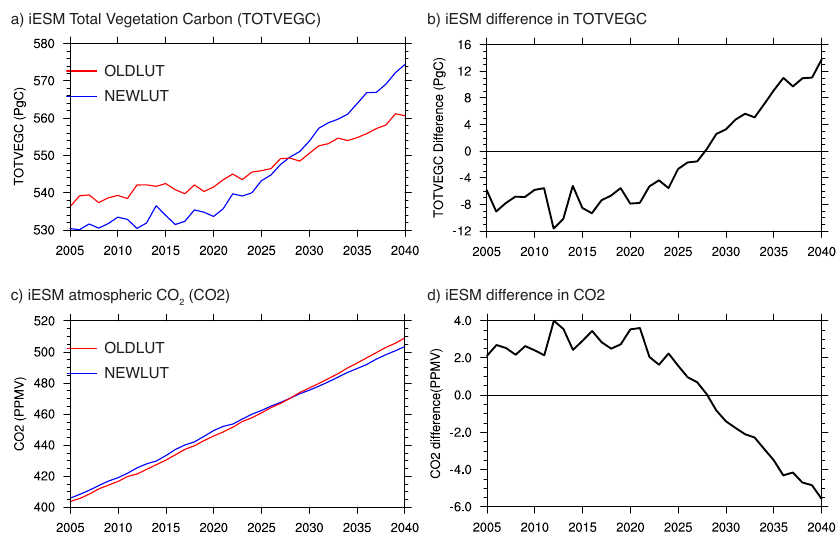
Figure 10. Comparison between iESM simulations of (a – b) vegetation carbon and (c – d) atmospheric CO 2 concentration. Differences are NEWLUT minus OLDLUT. Due to additional forest area, the NEWLUT simulation significantly increases vegetation carbon gain and decreases atmospheric CO 2 gain over the OLDLUT